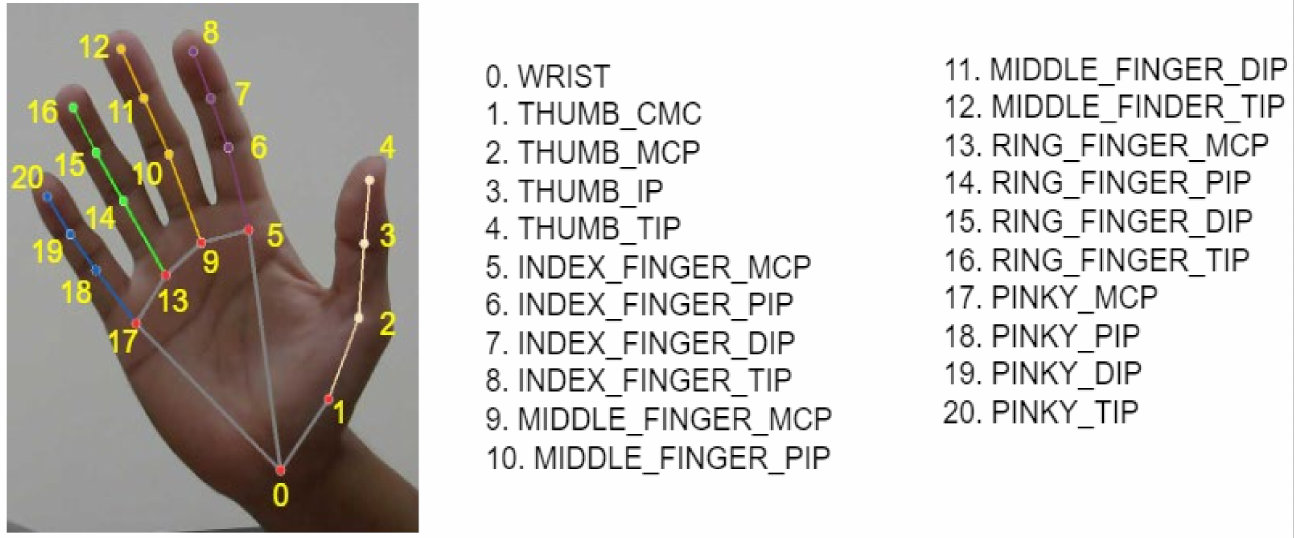
Figure 5. Hand landmarks detected by Mediapipe